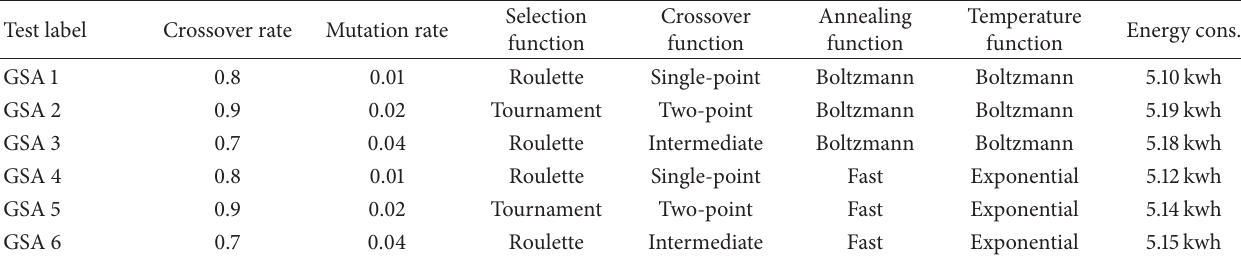
Table 3: GSA parameter selection